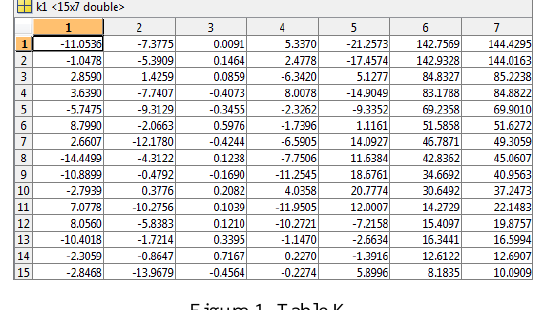
Figure 3. The requested angle